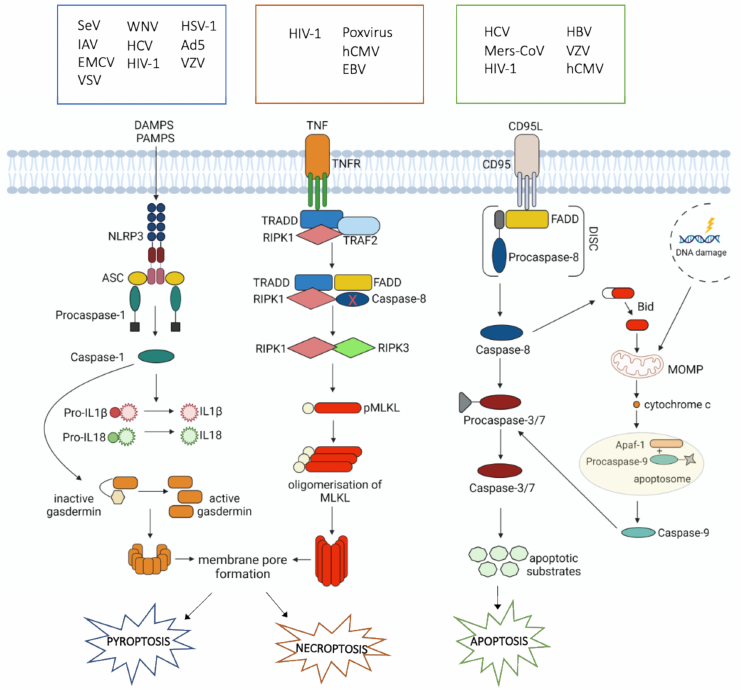
Figure 1. Principal mechanisms involved in pyroptosis, necroptosis, and apoptosis triggered by viral infections. Damage-associated molecular patterns (DAMPS), pathogen associated molecular patterns (PAMPS), NLR family pyrin domain-containing 3 (NLRP3), apoptosis-associated speck-like protein containing a CARD (ASC), interleukin1 β (IL1 β ), interleukin18 (IL18), tumor necrosis factor (TNF), tumor necrosis factor receptor (TNFR), tumor necrosis factor receptor type 1-associated death domain protein (TRADD), Fas-associated protein with death domain (FADD), TNF receptor-associated factor 2 (TRAF2), receptor-interacting serine/threonine-protein kinase 1 (RIPK1), receptor-interacting serine/threonine-protein kinase 3 (RIPK3), p-MLKL: phosphorylated mixed lineage kinase domain- like, CD95 ligand (CD95L), apoptotic protease activating factor-1 (APAF-1), death-inducing signaling complex (DISC), mitochondrial outer membrane permeabilization (MOMP), Hepatitis C virus (HCV), Middle East Respiratory Syndrome Coronavirus (Mers-CoV), Human Immunodeficiency virus 1 (HIV-1), Hepatitis B virus (HBV), Varicella Zoster virus (VZV), Human Cytomegalovirus (hCMV), Epstein–Barr virus (EBV), Sendai virus (SeV), Influenza A virus (IAV), Encephalomyocarditis virus (EMCV), Vesicular Stomatitis virus (VSV), West Nile virus (WNV), Herpes Simplex virus 1 (HSV-1), Adenovirus type 5